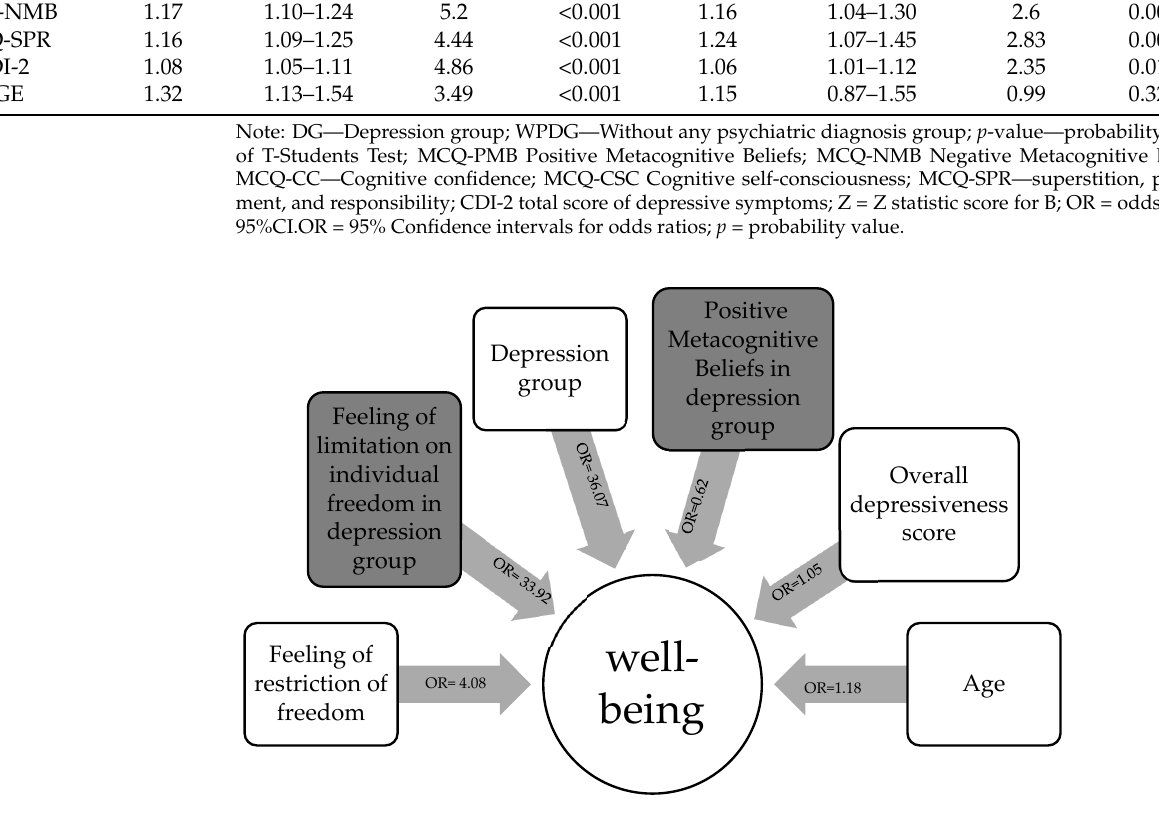
Figure 3. Graphical depiction of a multidimensional model of adolescents’ well-being during the COVID-19 lockdown.